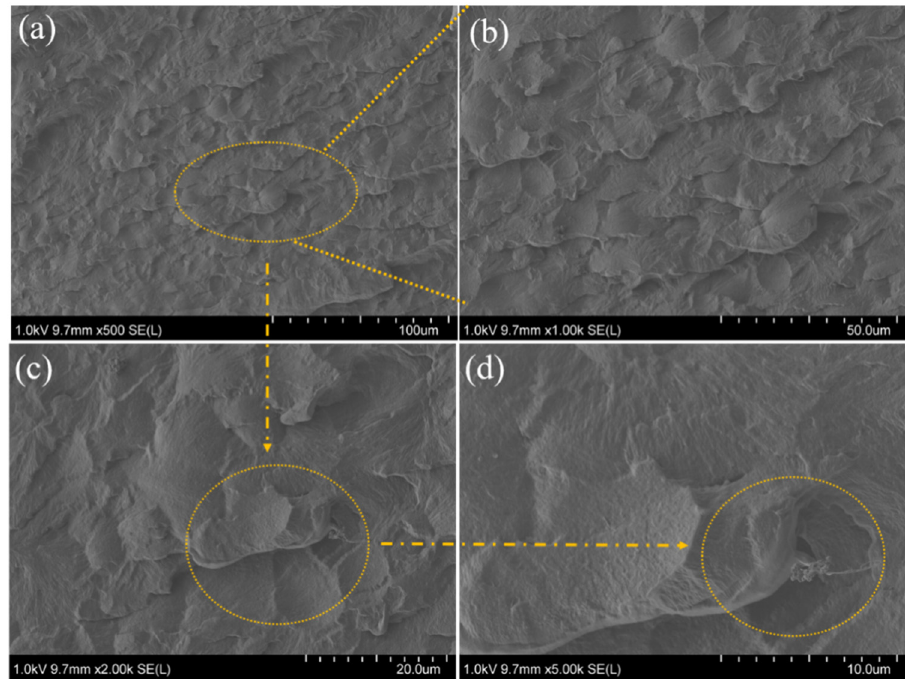
Figure 4: SEM images of EP/SiC - M3 with di ff erent ampli fi cation